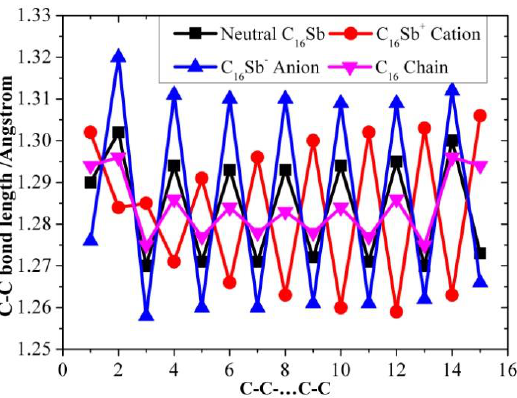
Figure 2. C-C bond length alteration of neutral C 16 Sb,C 16 Sb + cation, C 16 Sb − anion, and pure carbon chain C 16 as a function of number of carbon atoms.